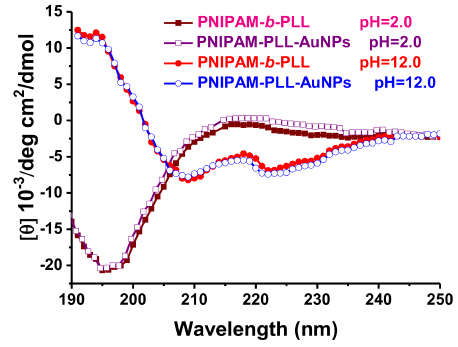
Figure 6. CD spectra of PNIPAM- b -PLL and PNIPAM-PLL-AuNPs under pH = 2.0 and pH = 12.0 at room temperature (Concentration: 2.0 mg/mL).